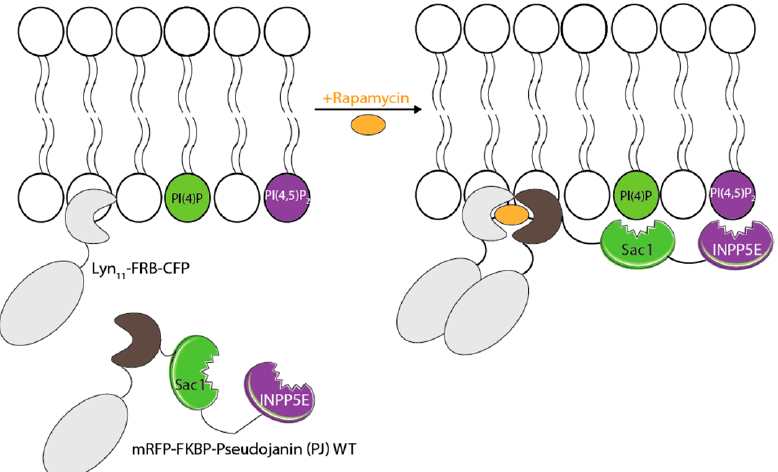
Figure 8. Schematic depicting the principle of the lipid depletion assay using phosphatases. The Pseudojanin (PJ) construct generates a fusion of Sac1 and INPP5E phosphatase domains with FKBP (mRFP-FKBP-PJ-WT). After rapamycin treatment, the mRFP-FKBP-Pseudojanin (PJ) WT construct is recruited to the plasma membrane (PM) due to the dimerization of its FKBP domain to a PM targeted FRB domain (Lyn 11 -FRB-CFP). The information presented stems from